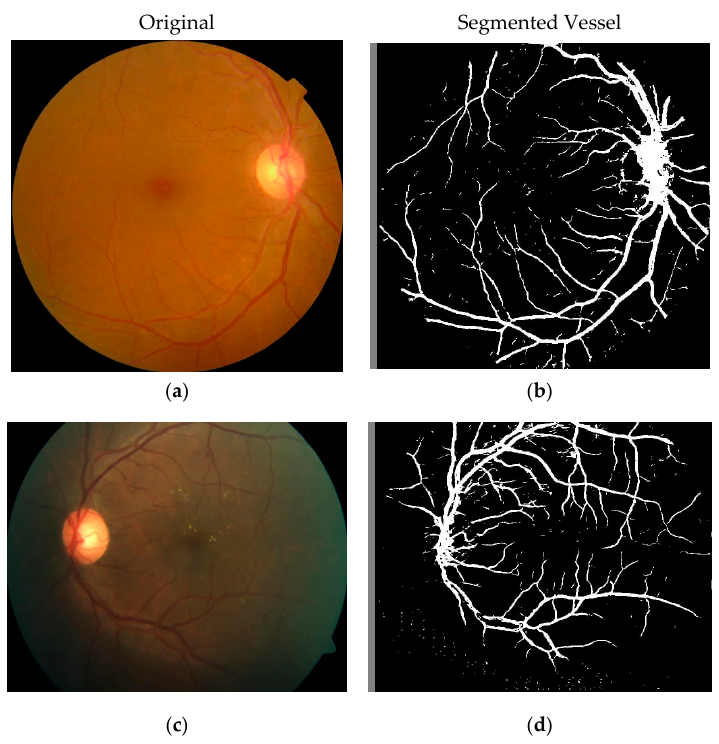
Figure 1. Image before segmentation and after segmentation stage. ( a , c ) Images before segmentation and ( b , d ) images after segmentation of their respective original images.